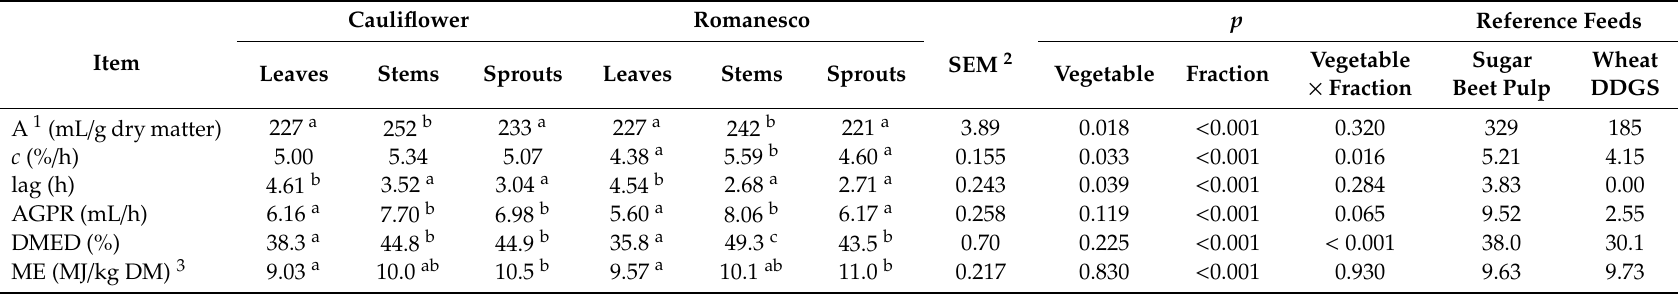
Table 2. Gas production parameters of di ff erent fractions of cauliflower and Romanesco and two reference feeds (sugar beet pulp and wheat DDGS) measured using sheep rumen fluid as inoculum. Cauliflower Romanesco Item Leaves Stems Sprouts Leaves Stems Sprouts Vegetable Fraction